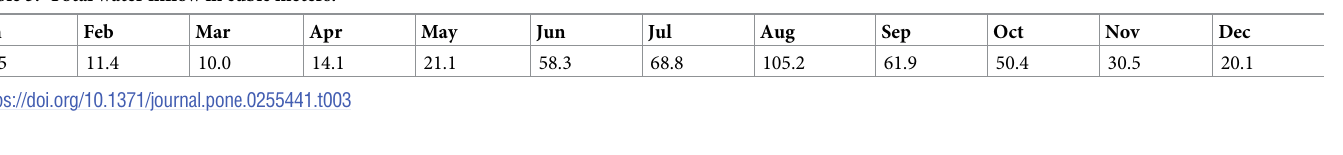
dominance and non-dominance relation and to determine Pareto solutions. It is an extension and improvement of NSGA, proposed earlier by Srinivas and Deb [22]. Also, it is an elite and fast sorting multi-objective genetic algorithm. The NSGA-II has three unique properties: sim- ple crowded comparison operator, fast non-dominated sorting approach, and fast crowded distance estimation procedure [21]. The pseudocode of the NSGA-II is given next.